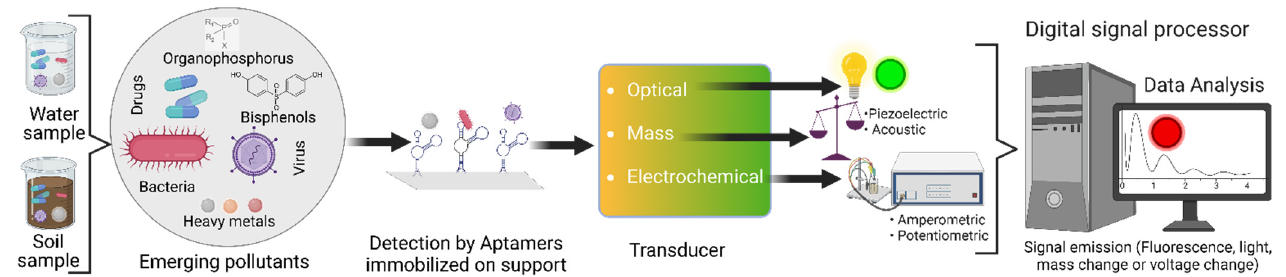
Figure 2. Schematic representation showing the operation of an aptasensor. The soil or water sam- ples are loaded onto the surface of the device, in which the aptamers are immobilized. After the aptamers bind with their target (heavy metals, drugs, bacteria, viruses, or endocrine-disrupting chemicals), they change their conformation and release signals of chemiluminescence, fluorescence, mass change, and changes in electric charge, among others. Created with BioRender.com.